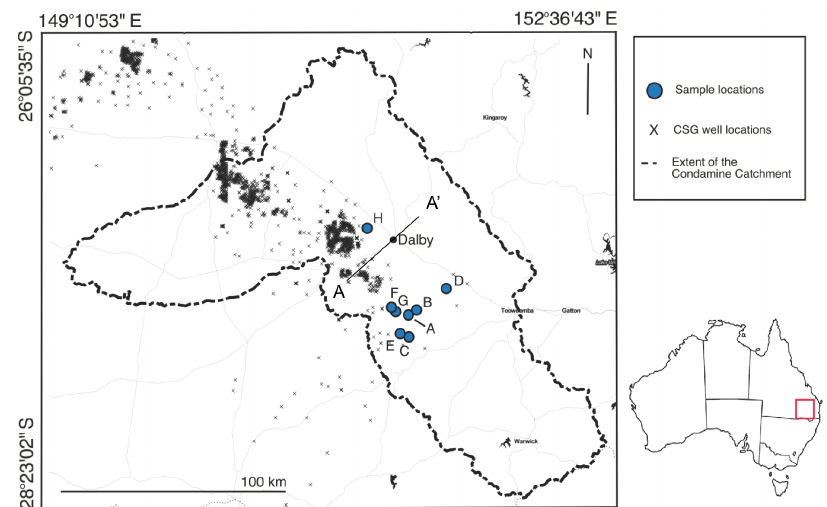
Figure 1. Site map showing the extent of the study area and sample locations within the Condamine Catchment, south-east Queensland, Australia. Map created in QGIS; data and imagery: Statem Toner, Open Street Map and contributors, CC-BY-SA (QGIS 2.8.2 Wien, 2015). Modified with Corel Painter 2015 (Corel Corporation, 2015).